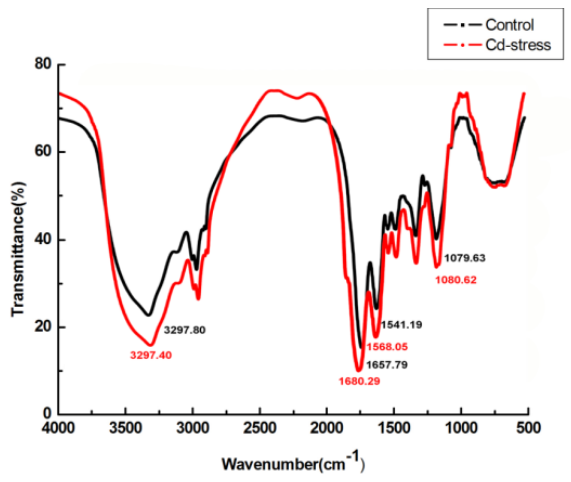
Figure 5. FTIR image of P. shigelloides H5 with and without Cd 2+ stress.